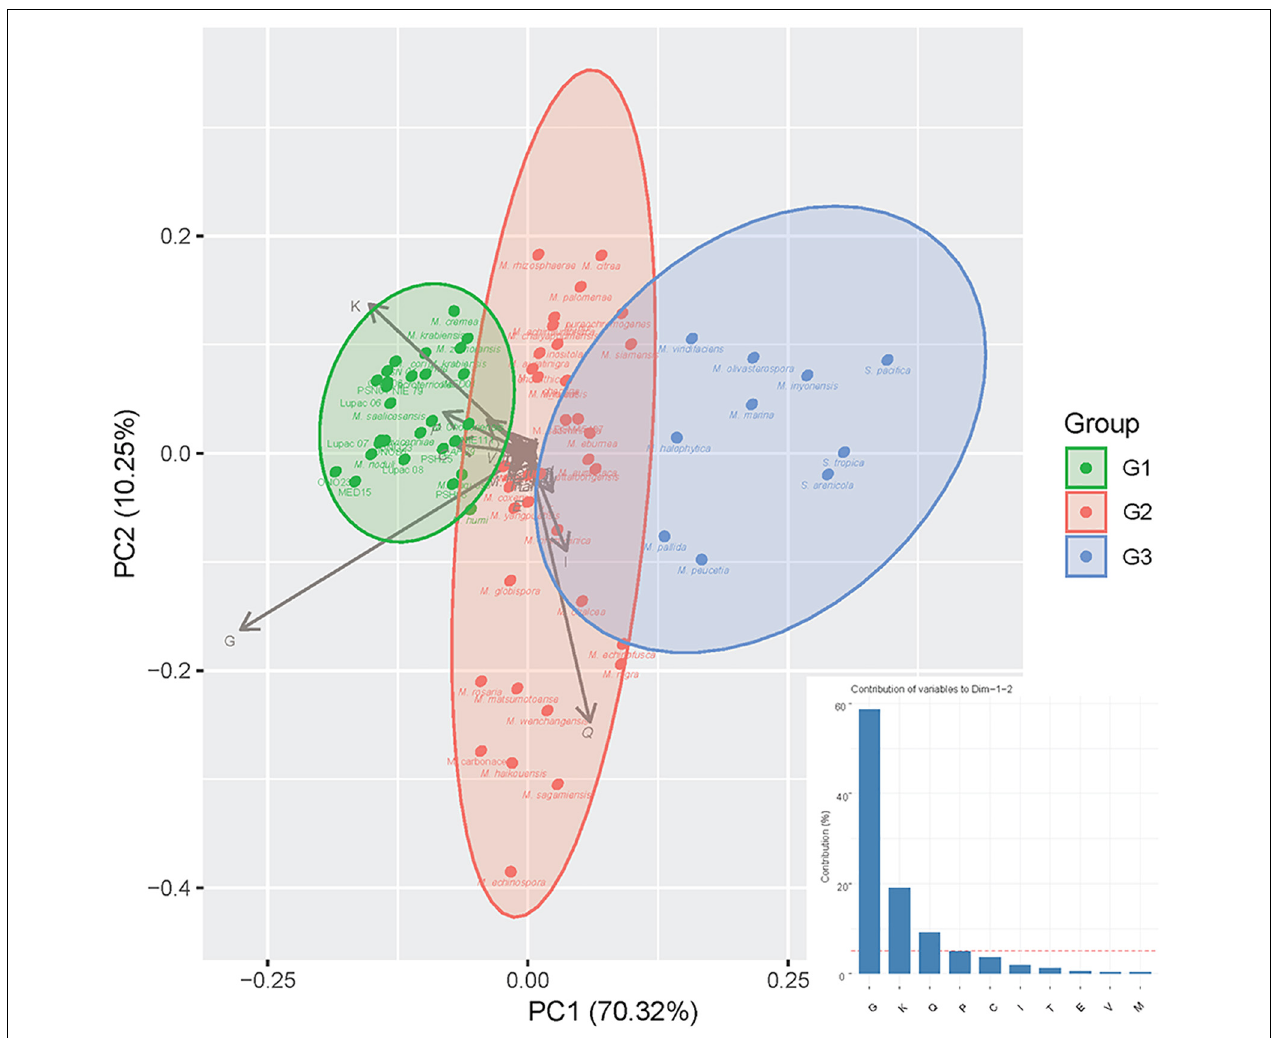
FIGURE 2 | Principal component analysis (PCA) of putative plant-related genes according to COG categories with strains recovered in groups G1, G2, and G3, respectively (for Group composition, see Section “Results”). The bar graph represents the contribution (%) of each COG category to dimensions 1 and 2 of the